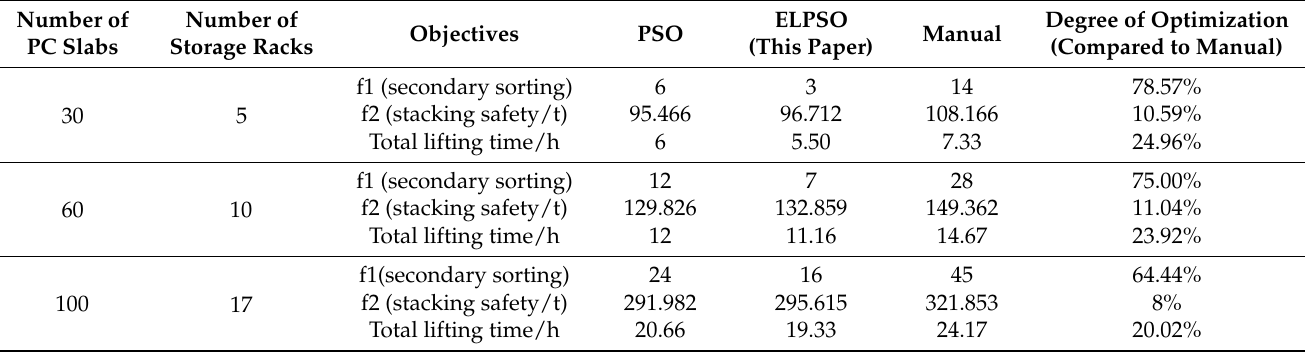
Table 2. Comparison between the actual stacking plan manually generated by the stacking planners during the project and the stacking plan generated by the optimization algorithm for the case